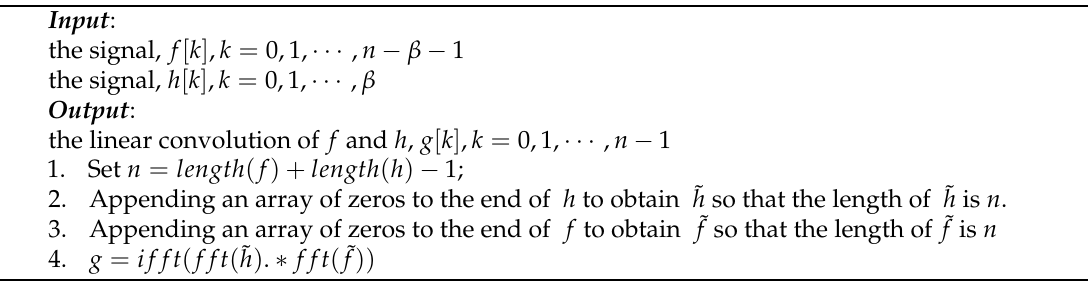
Algorithm 1: FFT-based fast method for linear